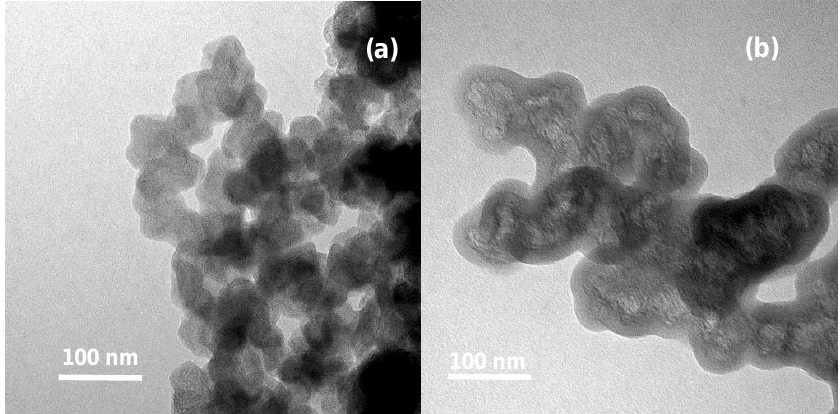
Figure 2. TEM images of ( a ) pristine carbon black and ( b ) HBSPES/CB [9].